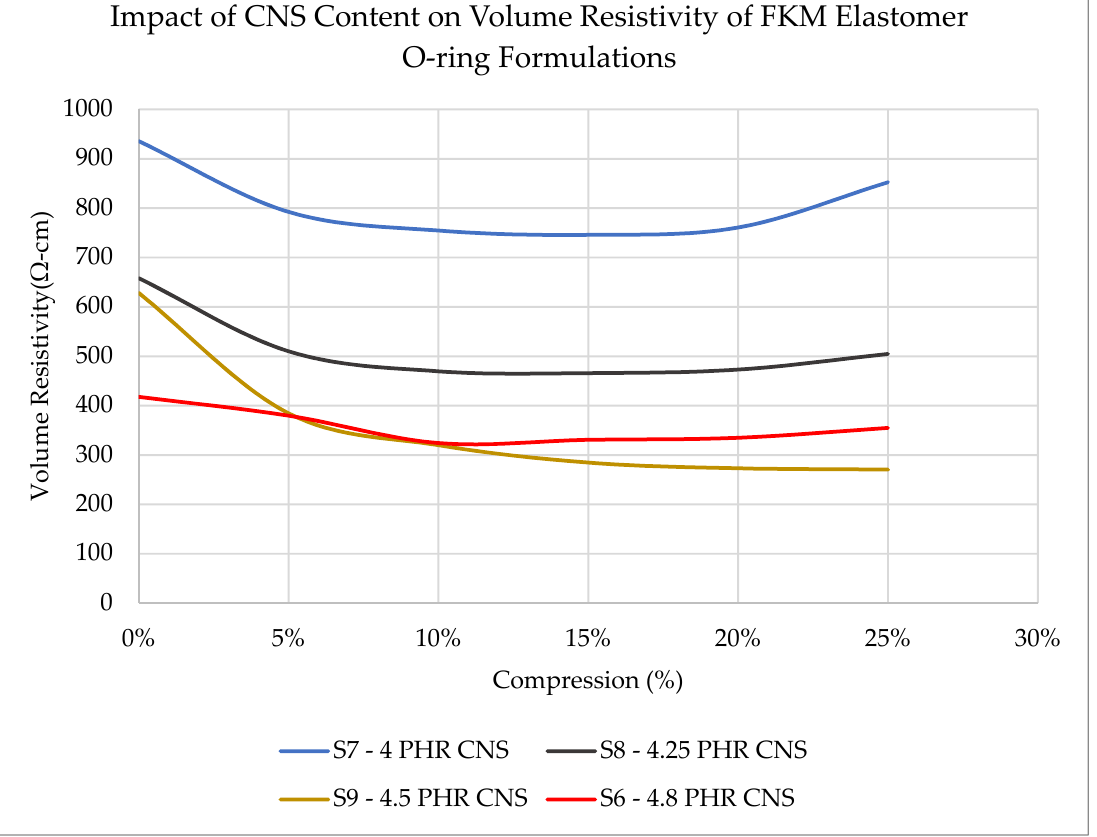
Figure 3. Effect of CNS content in the range of 4.0 to 4.8 PHR within elastomer O-rings on volume resistivity across multiple compression levels.